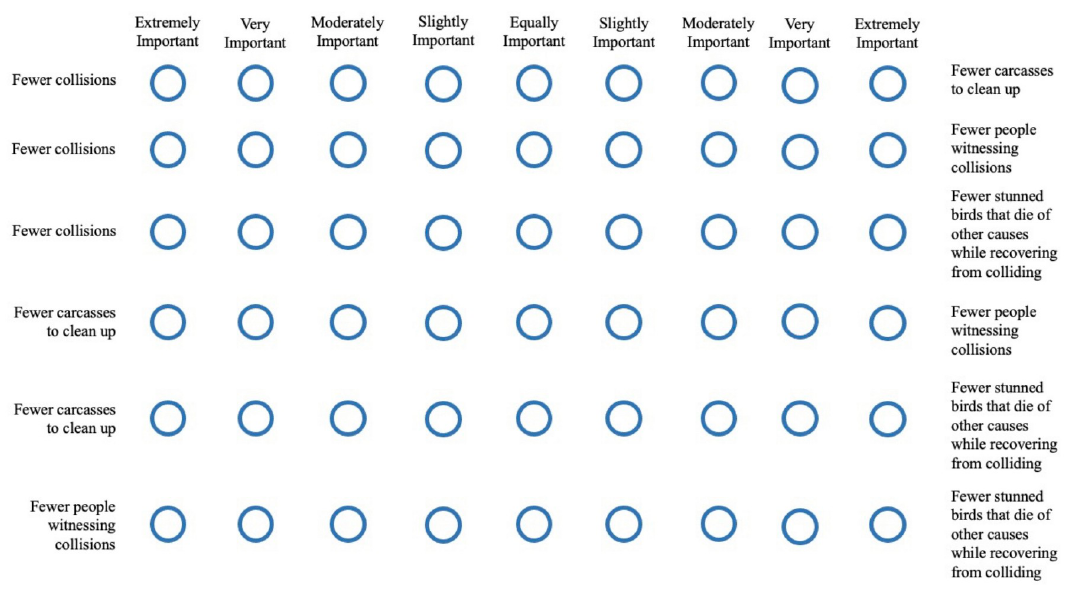
Fig 1. SWOT survey example. Examples of pairwise comparisons within the strengths category of the strengths, weaknesses, opportunities, and threats (SWOT) analysis; this example illustrates the format of Survey 1 distributed to stakeholder groups to evaluate their perceptions and priorities regarding bird-window collision